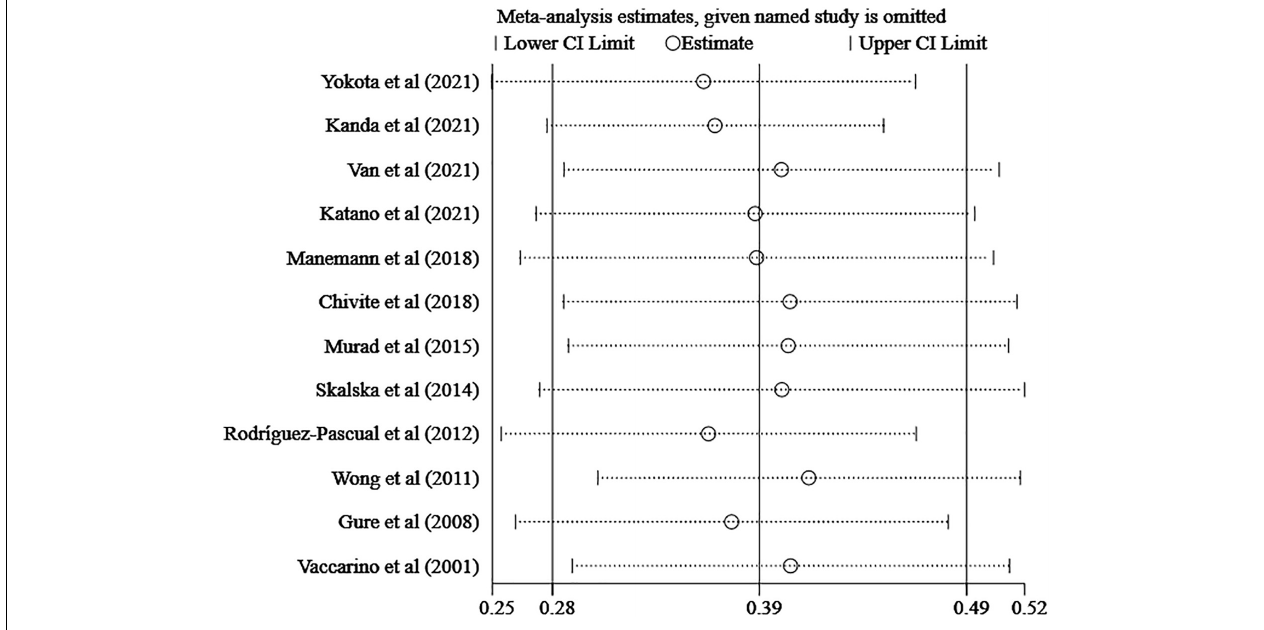
FIGURE 3 | Sensitivity analysis estimating